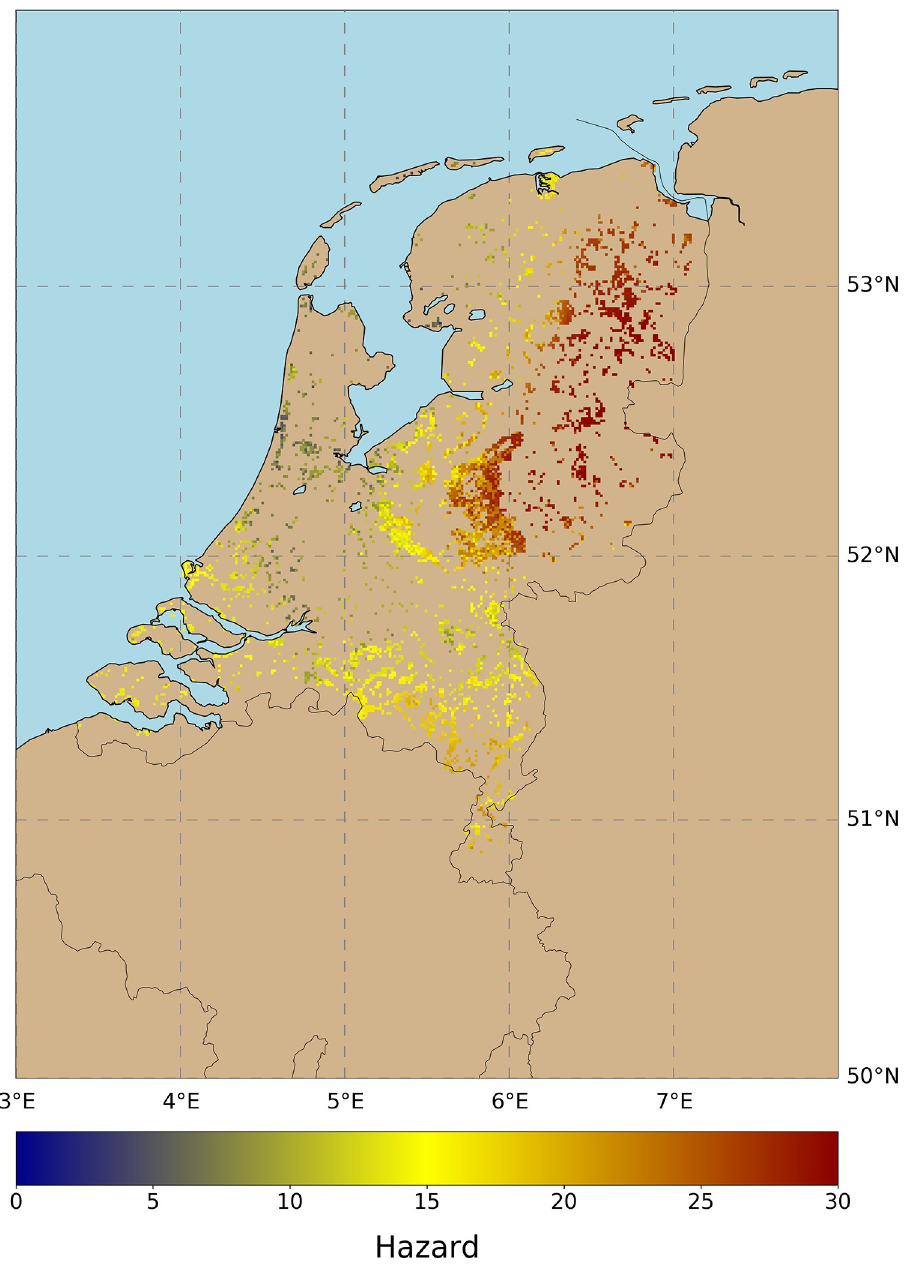
Fig 1. Tick activity per 1km grid cell. This tick activity estimation is provided by the data-driven model in [35], which is capable of predicting daily tick activity. We run this model for each day during the period (2006–2014) and we calculated a robust long-term metric of hazard, showing the maximum mean tick activity for the entire period. As seen, hazard is minimum along the coastline and maximum in the northeast of the country.